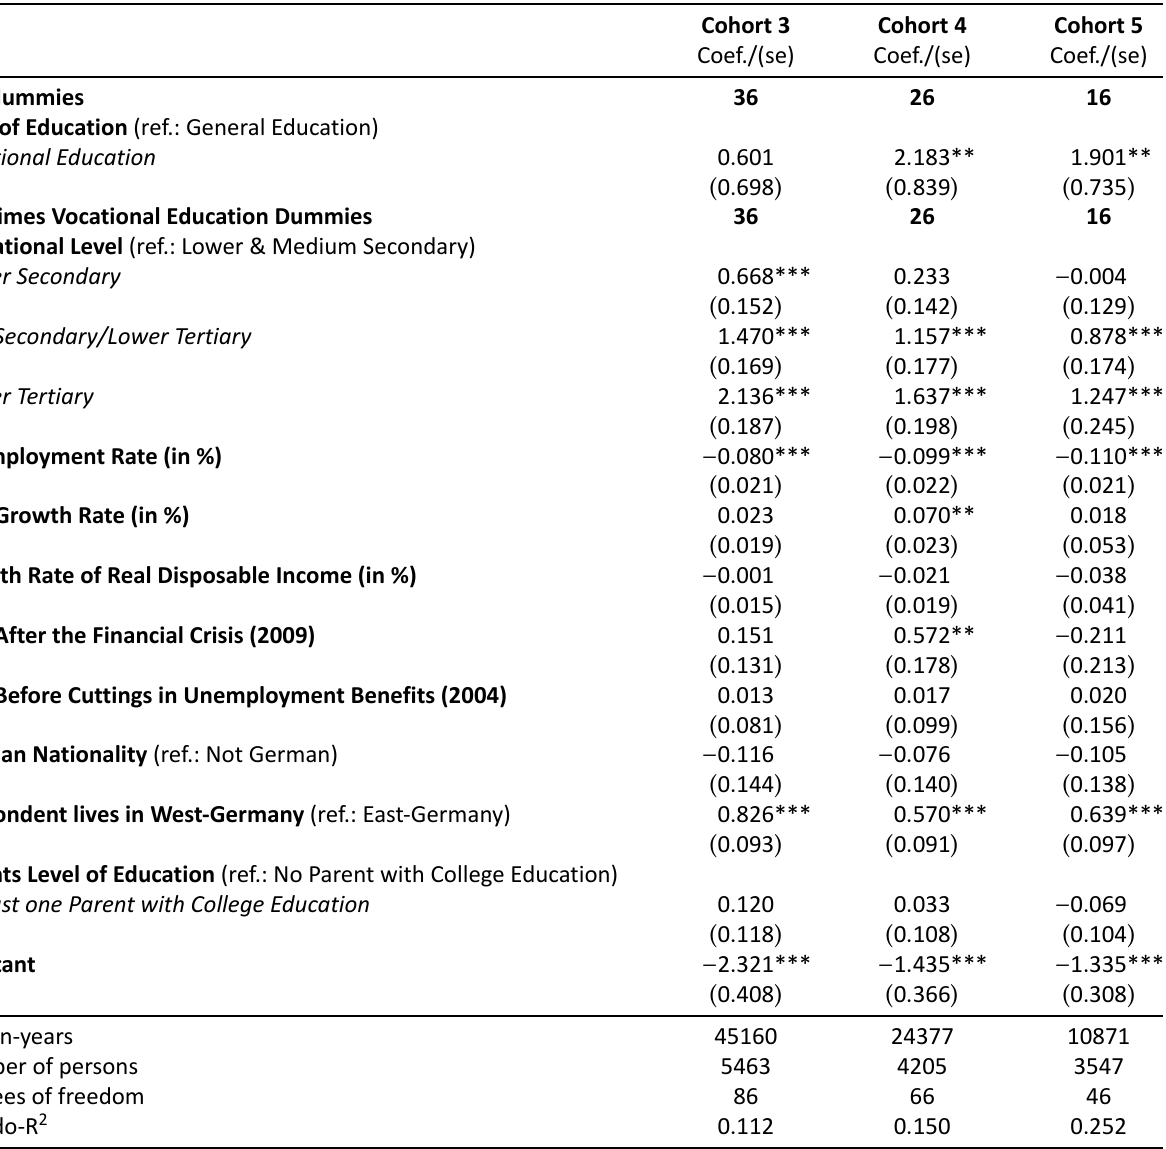
Table A8. Employment opportunity over the life course: General versus vocational education by cohort (men). Data source: GSOEP